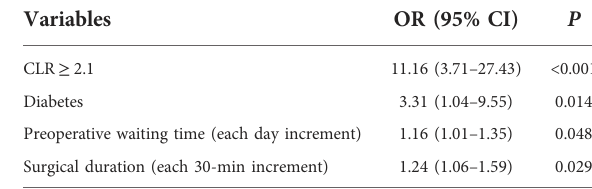
TABLE 2 Multivariate analysis of CLR in association with SSI after adjustment for numerous variables a .